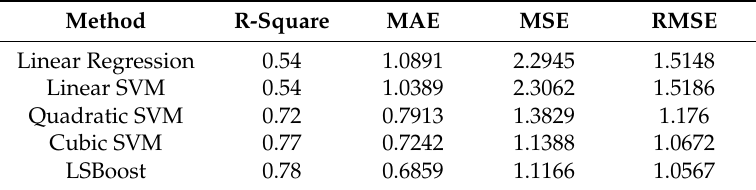
Table 6. Comparison of existing methods for the monthly